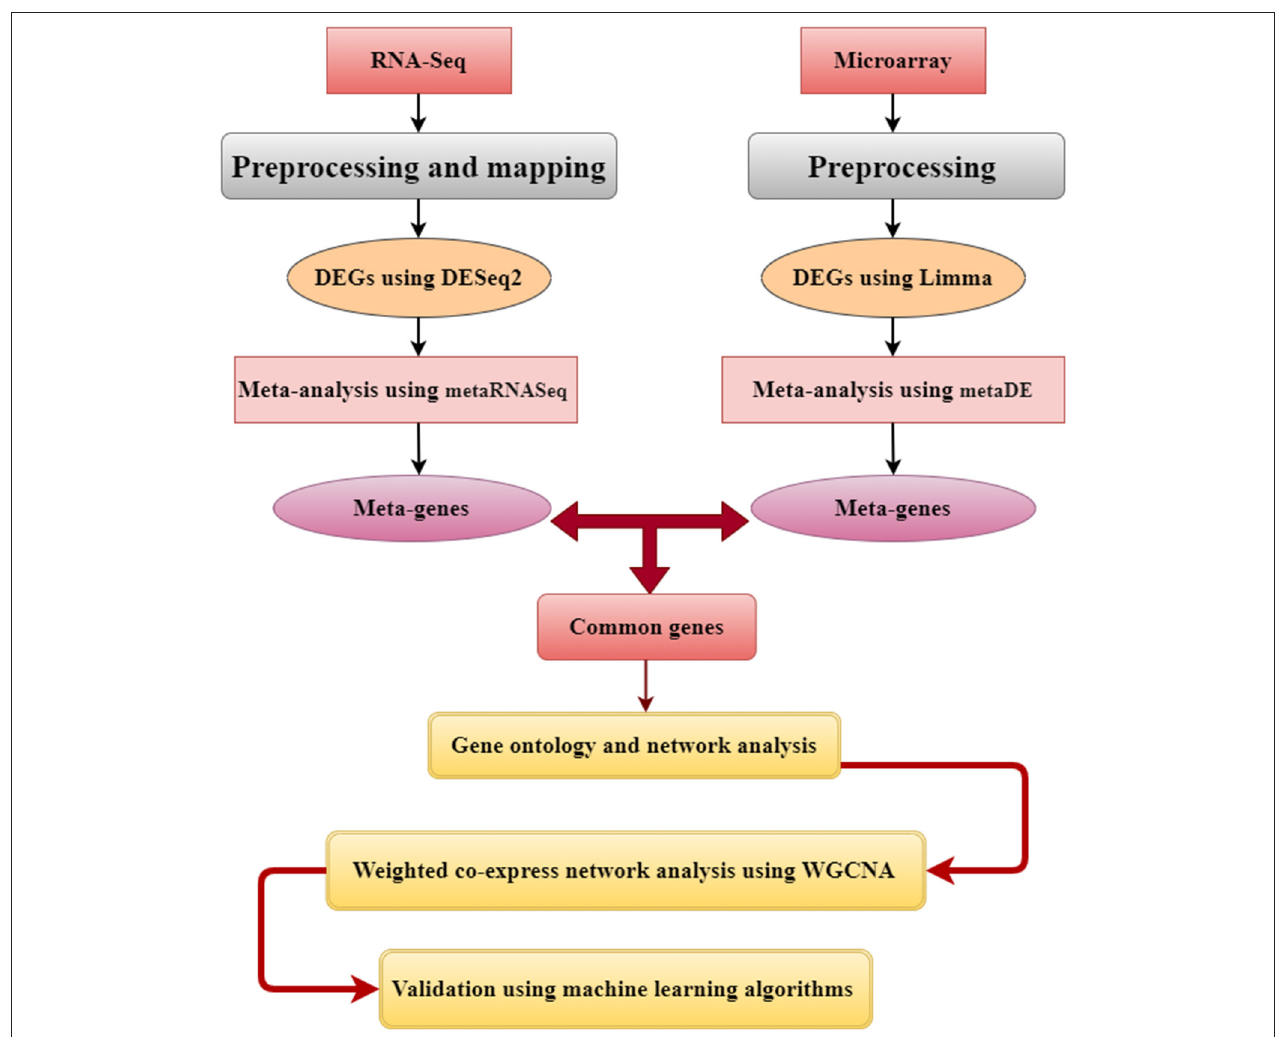
FIGURE 2 | Flowchart of applied systems biology approach in this